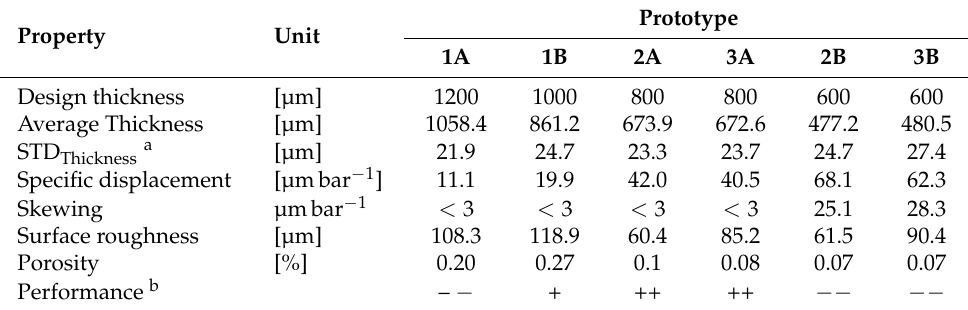
Table 2. The results of the microscopy image analysis and the scanning analysis; design thickness, average thickness, Standard deviation on the thickness (STD Thickness ), specific displacement ( | dD surface roughness and porosity for each investigated membrane. Each membrane has a lower average thickness as per design due to the surface roughness. The thinnest